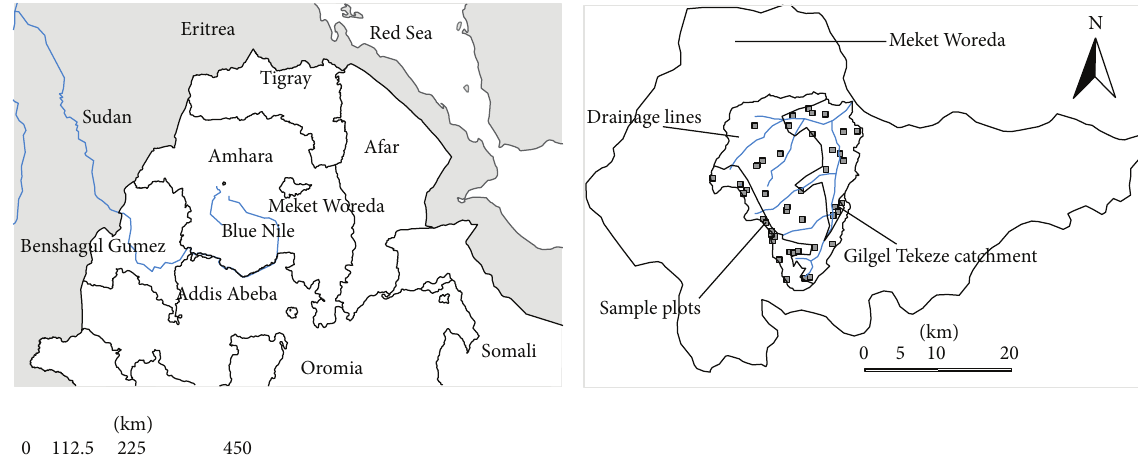
Figure 1: Location of study area: Gilgel Tekeze catchment, Amhara Region, Northern